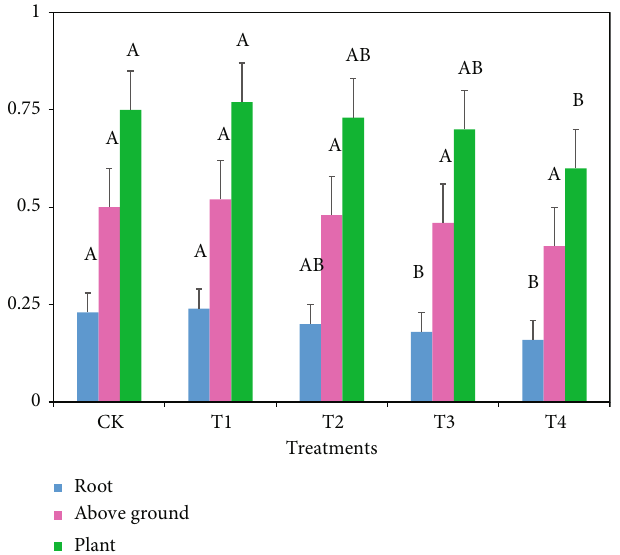
Figure 1: Dry weight of di ff erent parts of willow under copper